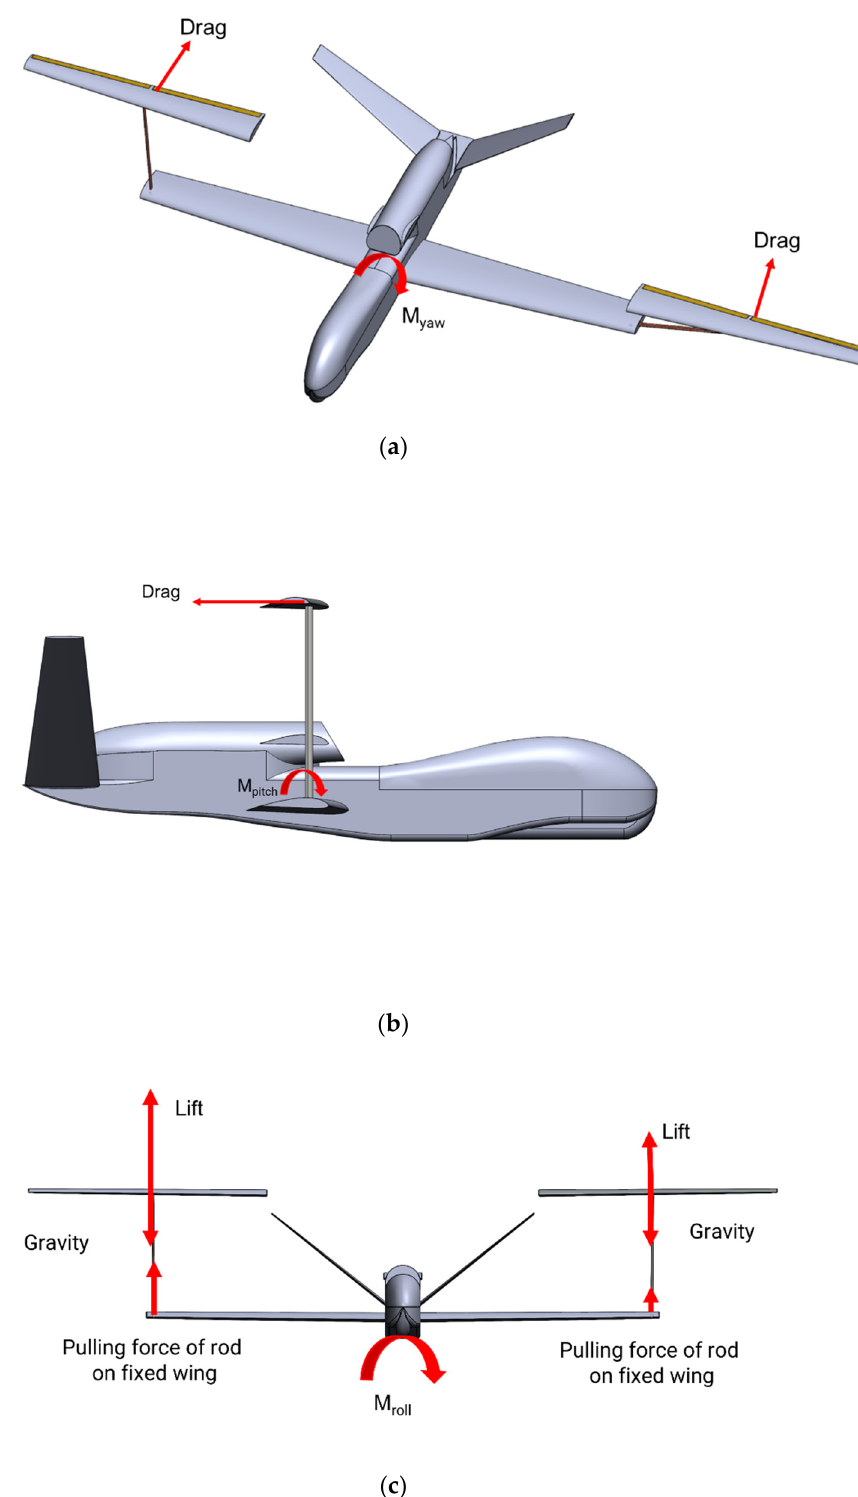
Figure 14. The extra moment that the aircraft assumes during the morphing process: ( a ) when the morphing on both sides is asymmetric, the drag produces a yaw moment; ( b ) the drag of the movable wing will cause a pitching moment; ( c ) the unbalanced lift of the two movable wings will produce a rolling moment.